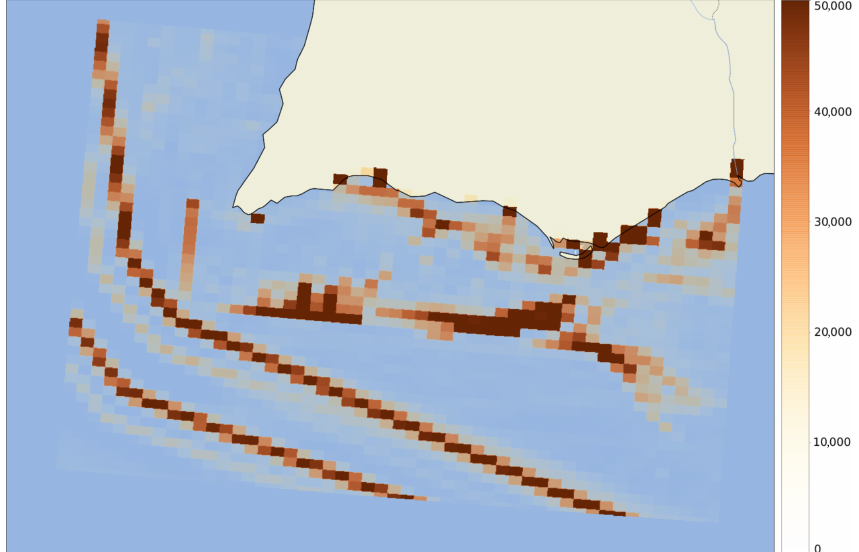
Figure 1. Heatmap showing the total number of AIS messages received per each grid location on the map. A darker brown colour indicates a lot of messages have been sent from that particular location. We can clearly see a higher number of messages sent from locations of ports and from common navigational corridors used by vessels. June